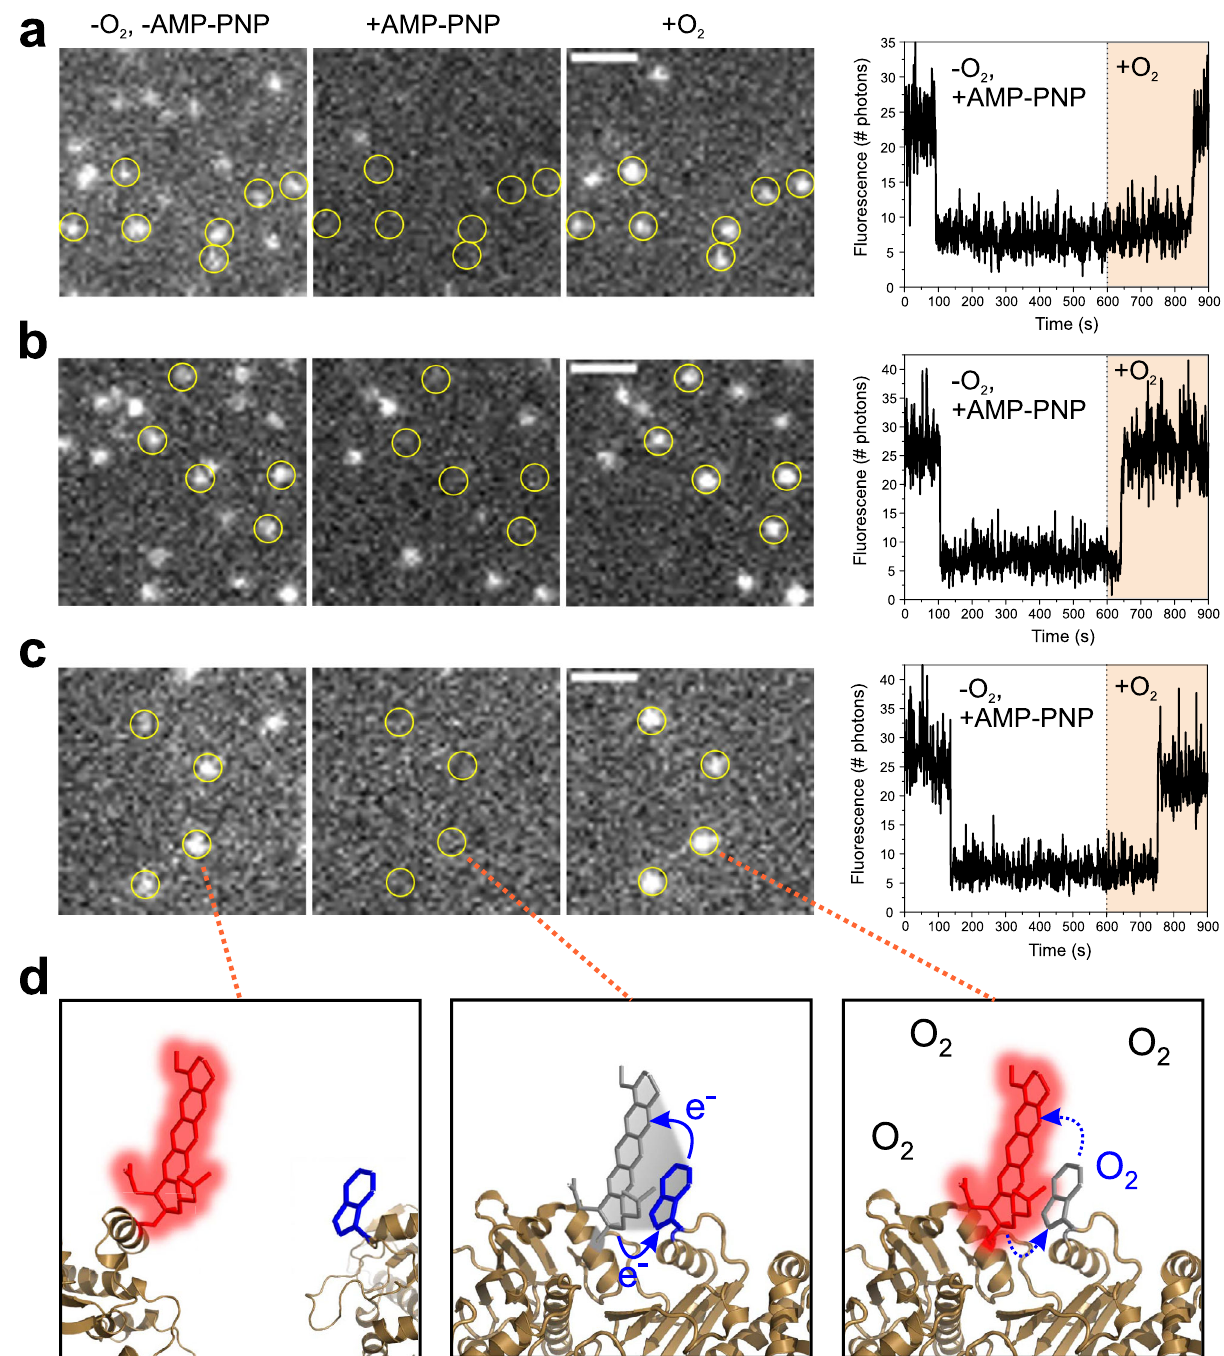
Fig. 2 One-colour smPET fl uorescence microscopy of Hsp90 dynamics. TIRF images of single, immobilized Hsp90 molecules modi fi ed with AttoOxa11 PET fl uorescence reporters for a DS, b Lid and c NM-association. White bars are 2- µ m scale bars. For each reporter a time series of images is shown recorded in (i) oxygen-depleted solution before addition of AMP-PNP (-O 2 , -AMP-PNP), (ii) oxygen-depleted solution after addition of AMP-PNP ( + AMP- PNP), and (iii) after application of oxygen-rich solution following the addition of AMP-PNP ( + O 2 ). The respective conditions are indicated on top of panel a . Hsp90 molecules identi fi ed to undergo PET fl uorescence quenching through subsequent fl uorescence recovery by DSPO are highlighted by yellow circles. Panels on the right hand side show representative fl uorescence intensity time traces of individual Hsp90 molecules that undergo PET fl uorescence quenching followed by fl uorescence recovery through DSPO. AMP-PNP was applied at t = 0 s. Oxygen-rich solution was applied at t = 600 s. Experiments were repeated three times with similar results. Source data are provided as a Source Data fi le. d Functional principle of a PET fl uorescence reporter on Hsp90 (illustrated for NM-association in a series of molecular graphics images). Conformational change results in contact between fl uorophore (red sticks) and Trp (blue sticks). Fluorescence of the label is quenched through PET in oxygen-depleted solution (solid blue arrows). DSPO of Trp by molecular oxygen annihilates PET (broken blue arrows) and recovers fl uorescence of the